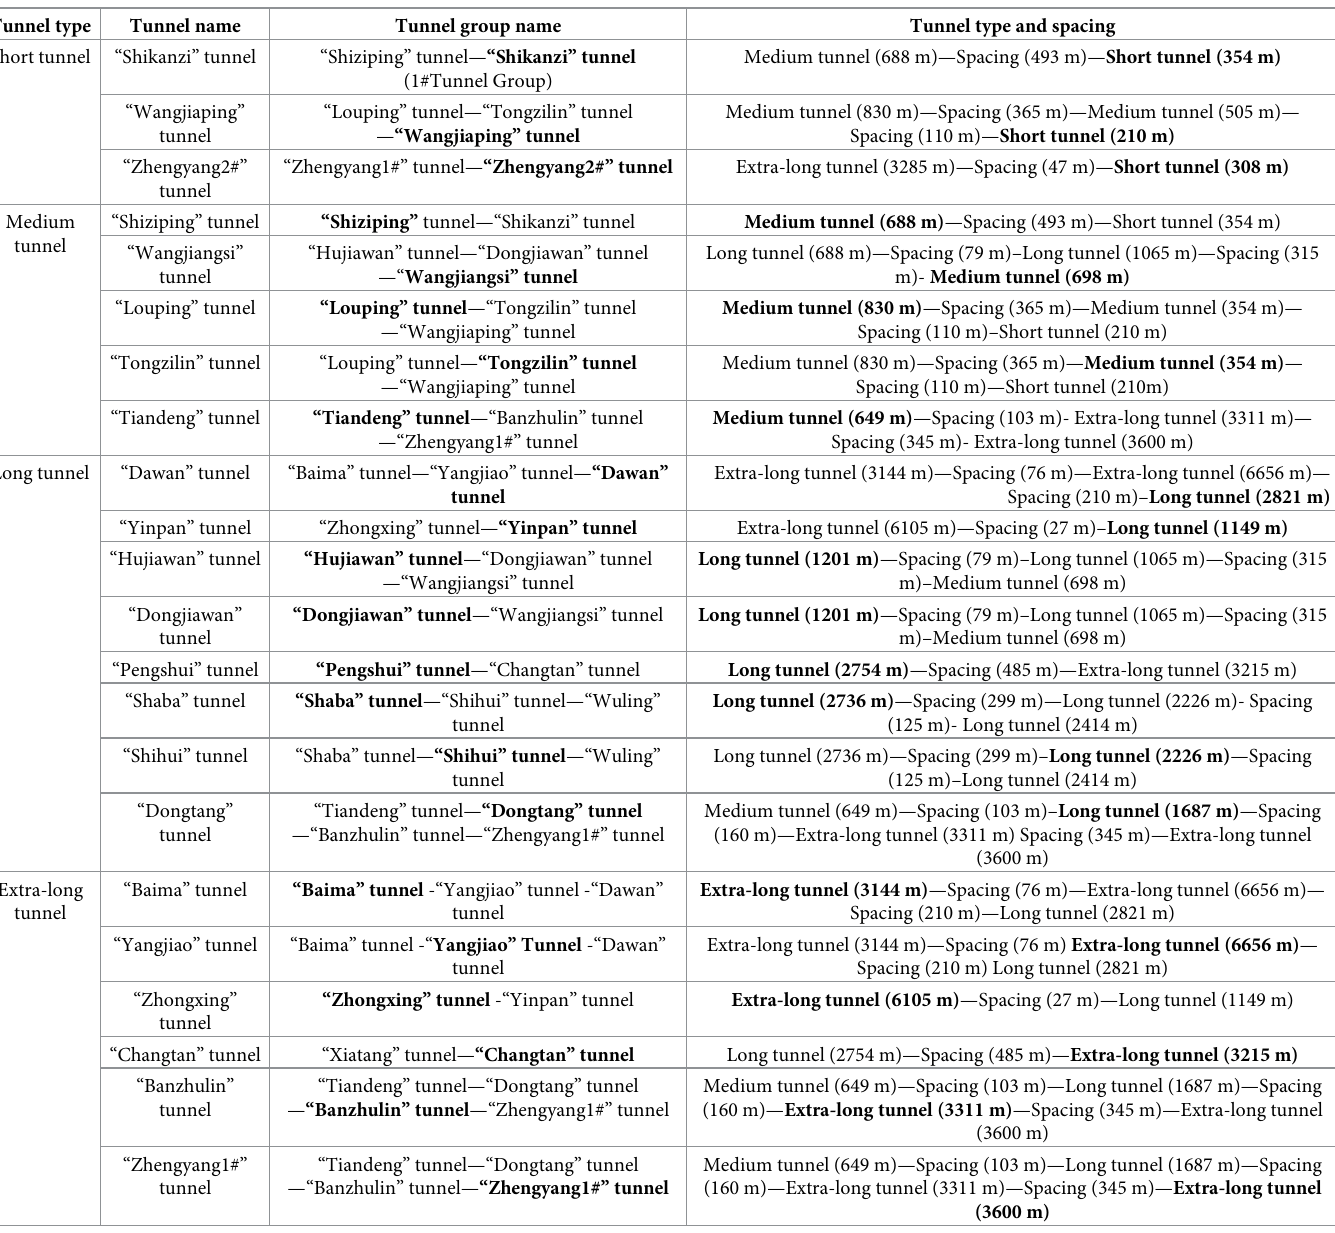
Table 1. Details of different tunnel type in tunnel